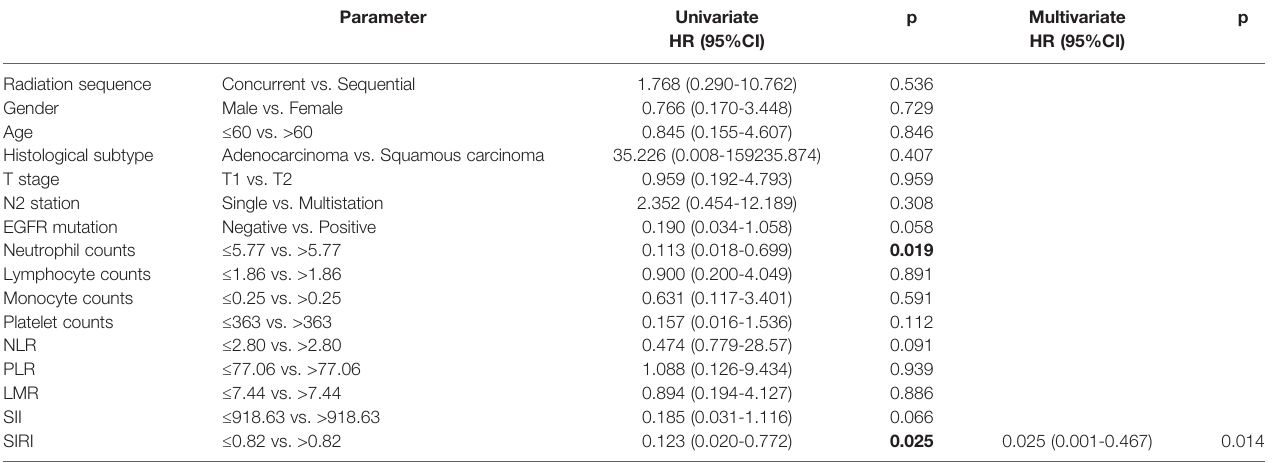
TABLE 3 | Univariate and multivariate analyses of